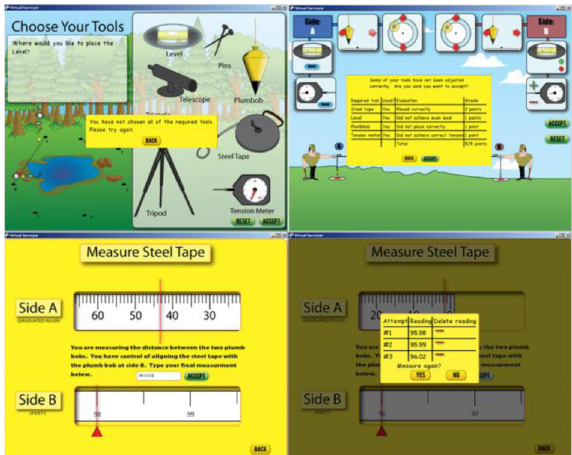
Figure 1. Screenshots of the student ’s virtual learning environment (VLE). Clockwise from top left: tool selec- tion screen with feedback to student; tool adjustments with feedback to the students (case of failure to achieve proper adjustments two consecutive times); recording of the tape measurement; option to review multiple mea- surements and delete outlier or erroneous